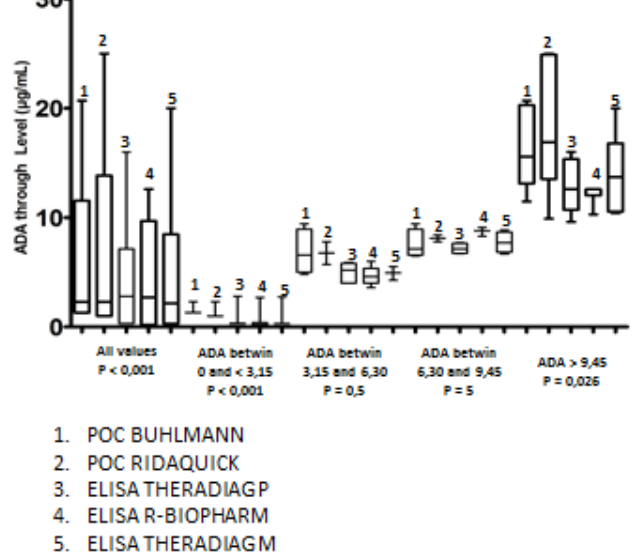
Figure 2. Comparison of interquartile ranges (μg/mL) between the different assays. Four quartiles were defined (0–C3.15, 3.15–6.3, 6.3–9.45, and ≥9.45 μg/mL). These results are without having defined a common upper and lower detection limit for all assays.